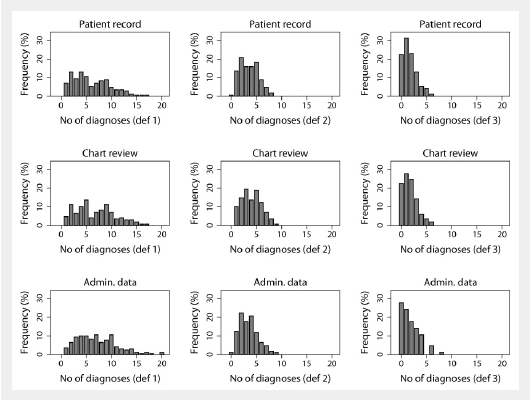
Frequency distribution of the number of diagnoses per patient based on three different data sources (rows) and three different definitions of multimorbidity (columns). The first column represents the frequency distribution of the number of diagnoses from the ICD-10 disease classification system within one patient (def 1). The second column represents the frequency distribution of the number of diagnoses from different organ-specific chapters of the ICD-10 classification system within one patient (def 2). The third column represents the frequency distribution of the number of diagnoses within one patient as defined by the Charlson/Deyo comorbidity index (def 3). Data sources for the first row are patient records (notes as cited by the treating physician), for the second row comprehensive chart reviews (two medical residents reviewed physician’s notes, medical charts, imaging and laboratory tests and appended diagnosis not mentioned in patient’s records), and for the third row administrative hospital discharge data (generated by a professional hospital coding team within 30 days of patient discharge from the hospital). The frequency distribution of the number of diagnoses within one patient is mainly determined by the definition of multimorbidity and not by the data source